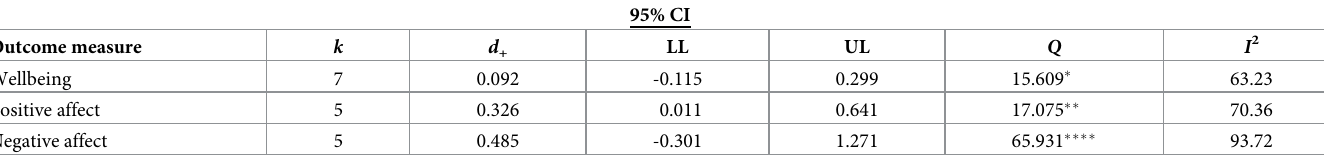
Table 4. Mean effect size, 95% confidence intervals, and heterogeneity statistics for the effectiveness of the BPS versus gratitude